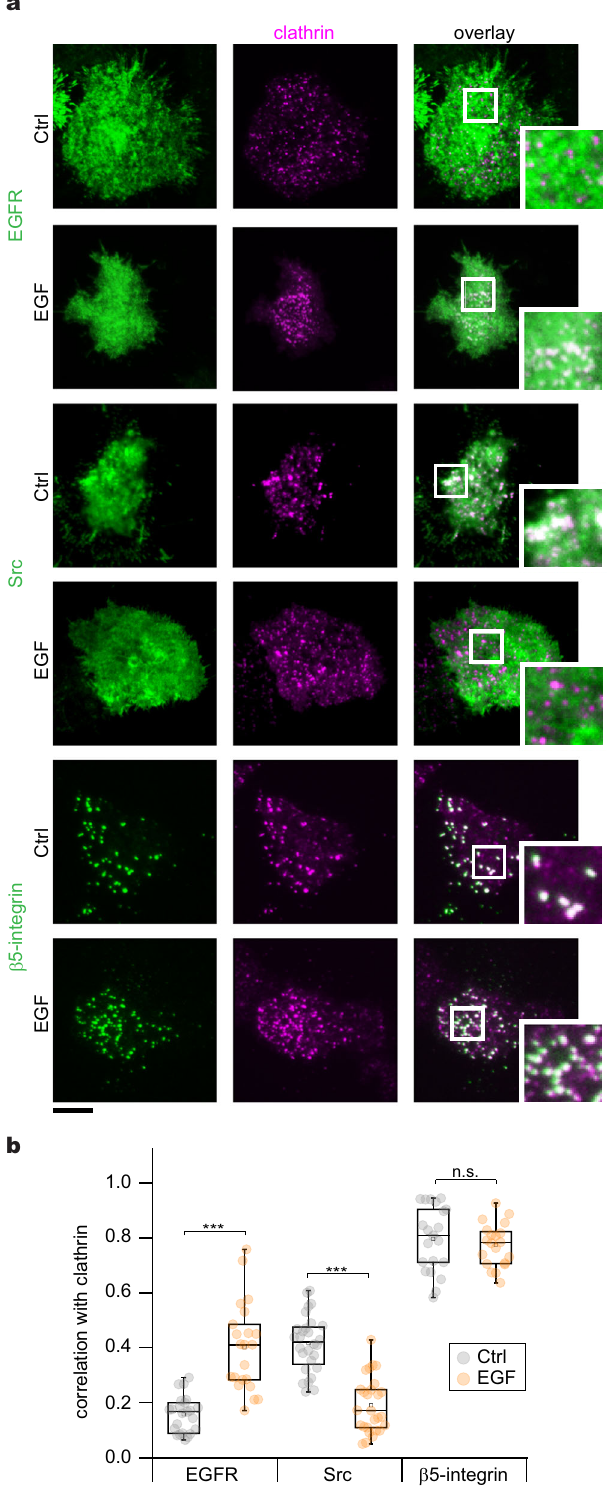
Fig. 5 Differential location of EGFR, Src, and β 5-integrin in clathrin- coated structures. a Representative two-color TIRF images of genome- edited HSC3 expressing EGFR-GFP and transfected with mScarlet-CLCa or HSC3 WT cells co-transfected with mScarlet-CLCa + Src-GFP or β 5- integrin-GFP before (Ctrl) or after 50 ng/mL EGF stimulation for 15 min. Scale bar is 10 μ m; insets are 7.3 μ m × 7.3 μ m. b Automated correlation analysis between clathrin and EGFR, Src, and β 5-integrin. Dot box plots show median extended from 25th to 75th percentiles, mean (square), and minimum and maximum data point whiskers with a coef fi cient value of 1.5. Signi fi cance was tested by a two-tailed t -test. EGFR, *** P = 5.9 × 10 − 7 ; Src, *** P = 1.7 × 10 − 11 ; β 5-integrin, ns P = 0.358. N = 4 biologically independent experiments with consistent results. N EGFR-Ctrl = 23 cells – 3728 spots, N = 22 cells – 2173 spots, N = 28 cells – 1394 spots, N EGFR-EGF Src-Ctrl Src- = 27 cells – 1407spots, N = 21 cells – 1037 spots; N = 20 β 5-Ctrl β 5-EGF EGF cells – 1011 spots examined over the indicated independent experiments.